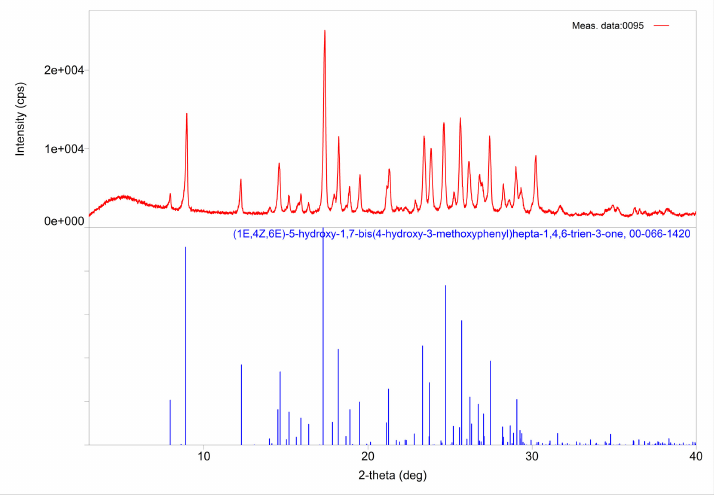
Figure S2: XRPD pattern for F_P80/SP_4:1. Reference XRPD pattern for curcumin (card number 00-066-1420; ICDD (PDF-2 Release 2016 RDB)) in blue is below the experimental